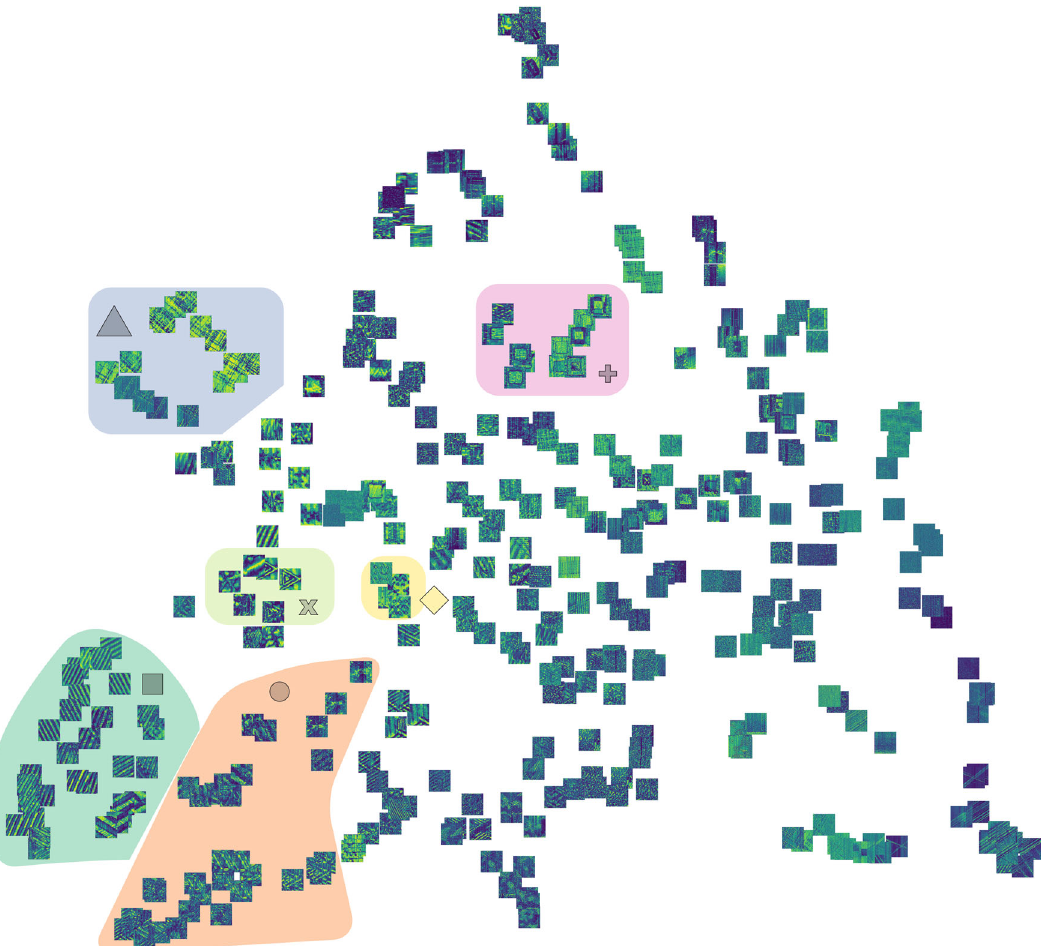
Fig. 5 UMAP projection of samples made by Dr. Ruijuan Xu. Regions of semantic similarity are identi fi ed. The hyperparameters for the UMAP were n_neighbors = 5, min_dist = 0.3, n_components = 2, metric = “ correlation ”